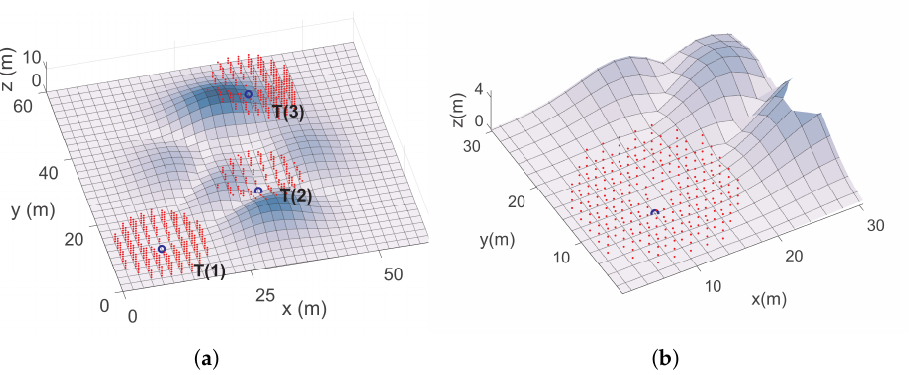
Figure 11. COPs and the partial zoom of the targets. ( a ) COPs of targets; ( b ) The partial zoom of T(1).